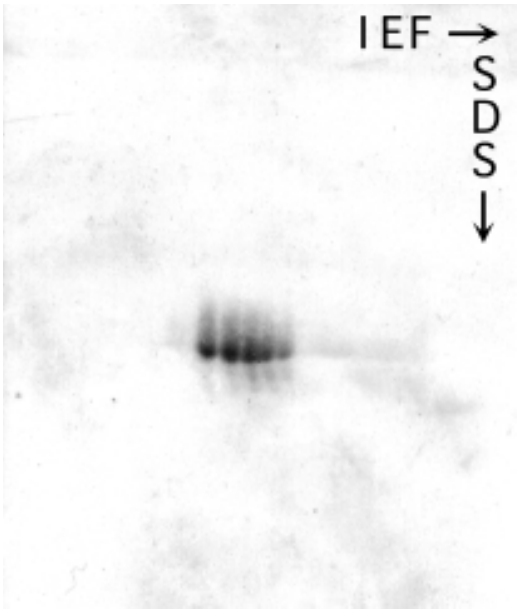
Fig. 1 – Bidimensional gel electrophoresis of purified desmin fromSachs’electricorganof E.electricus